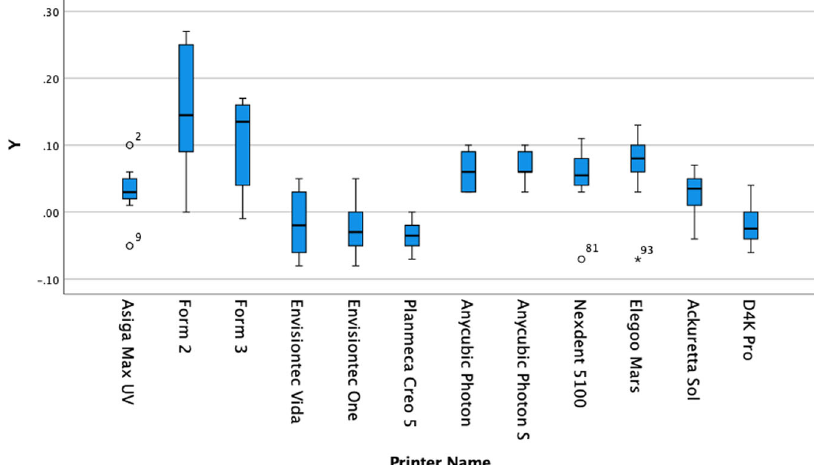
Fig. 4 Box plot of Y data set for each printer in the present study. The distribution of numerical data of the measurements of the Y dimension for each print and skewness through displaying the data quartiles and averages. The y-axis show the numerical data in terms of deviation from the actual size in microns and the x-axis labels each data set in terms of which printer it applies